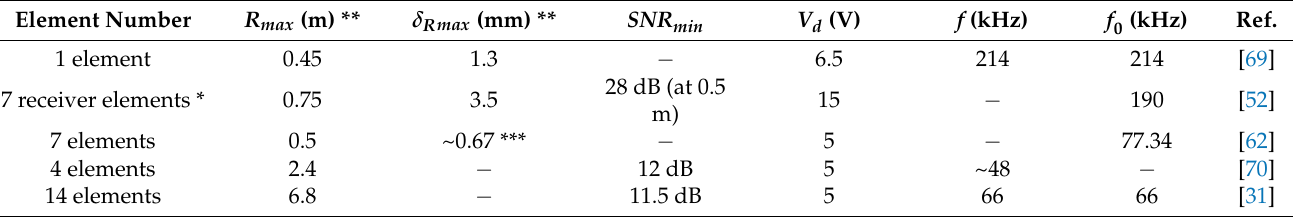
Table 3. Summary of a single pMUT rangefinder or rangefinder arrays with different